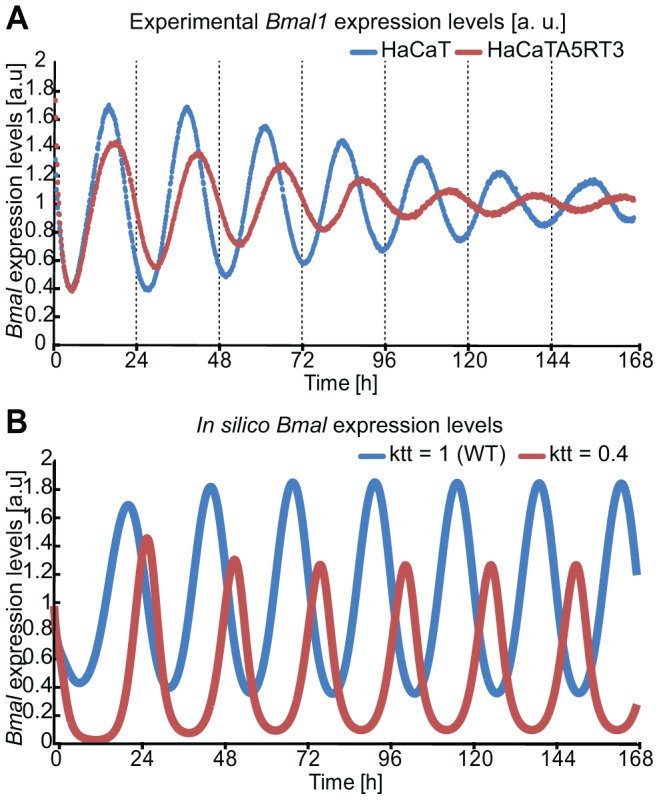
In silico perturbation of BMAL-mediated transcription reproduces HaCaT vs A5RT3 phenotype.(A) HaCaT and HRAS transformed HaCaT A5RT3 cells were synchronized with dexamethasone and after 24 hours harvested in regular 3-hour intervals. Shown are representative results from three independent experiments. Normal human keratinocytes shows an average free-running period of 22.9±0.2 hours (p<0.05, Student's t-test), and a peak at 15.9±0.4 hours (p<0.05, Student's t-test) after synchronization. H-Ras transformed HaCaT A5RT3, present a wide period (HaCaT A5RT3 24.5±0.1 hours p<0.05, Student's t-test) and a peak at 16.9±0.05 h (p<0.05, Student's t-test). (B) Shown are in silico expression profiles for Bmal1 obtained from simulations with our model over approximately 7 days. The blue curve represents the wild type (WT) non-perturbed situation (τ = 23 hours) and the red line represents the result of a perturbation in BMAL-mediated transcription (τ = 24.1 hours).